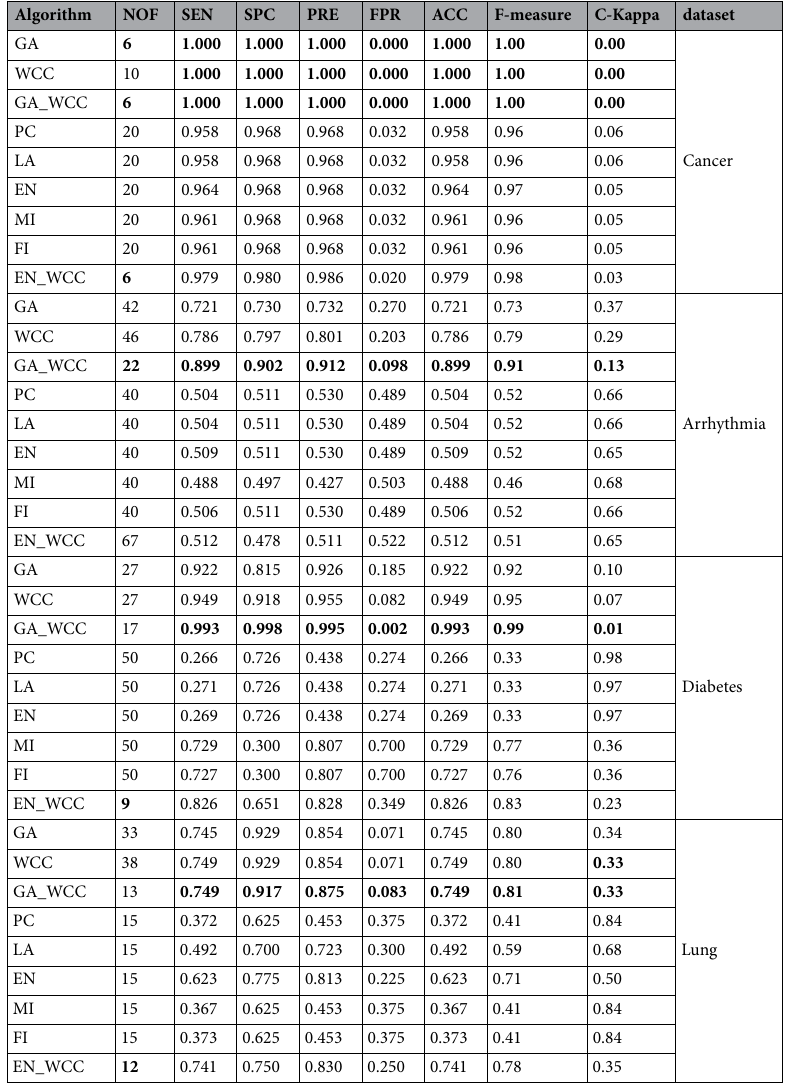
Table 2. Acquired outcomes based on fivefold cross-validation in the first class of results on the Cancer, Arrythmia, Diabetes, and Lung datasets. The best outcomes have been highlighted. NOF, number of features; SEN, sensitivity; SPC, specificity; PRE, precision; FPR, false positive rate; ACC, accuracy; C-Kappa, Cohen’s kappa coefficient; WCC, world competitive contests algorithm; GA, genetic algorithm; PC, Pearson correlation; LA, Laplacian score; EN, entropy; MI, mutual information; FI, Fisher